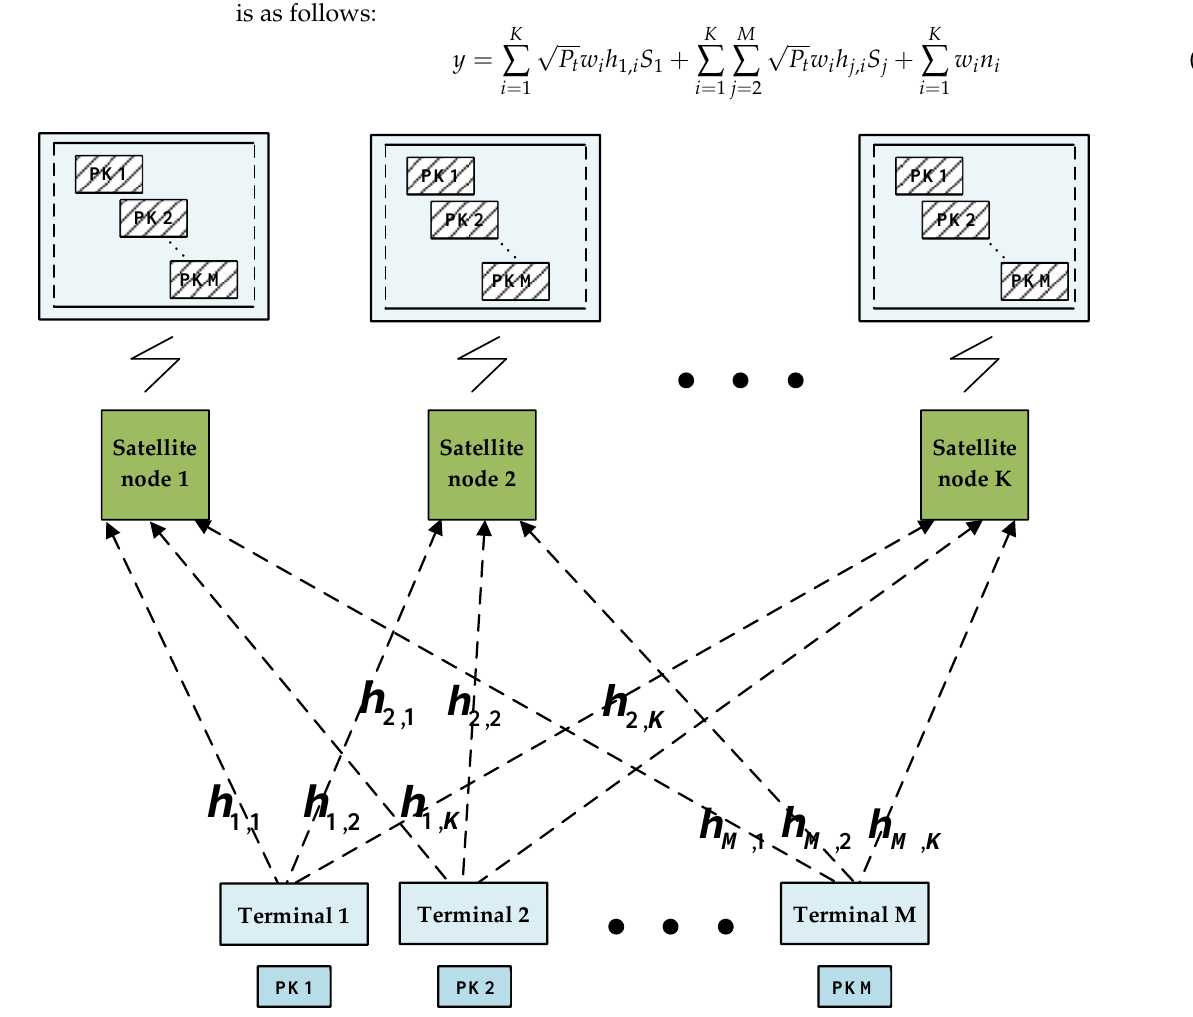
Figure 3. The relationship between terminals and satellite nodes when sending packets.